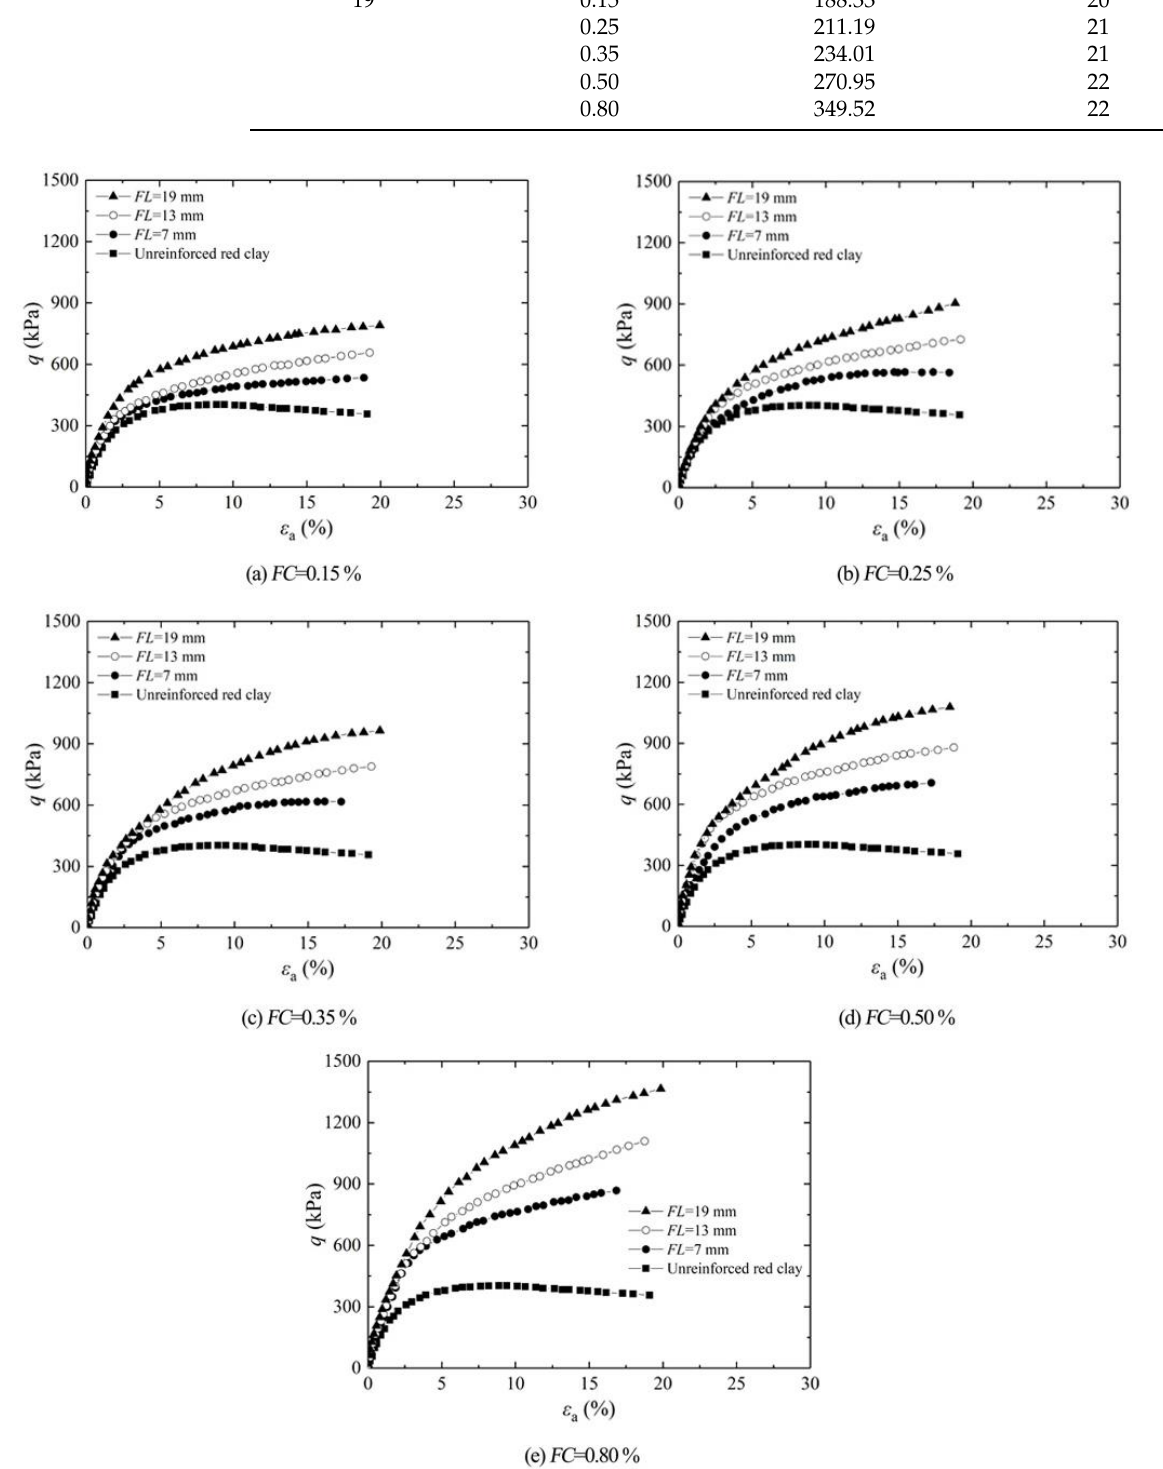
Figure 3. Effect of fiber length on stress-strain ( σ 3 = 200 kPa).